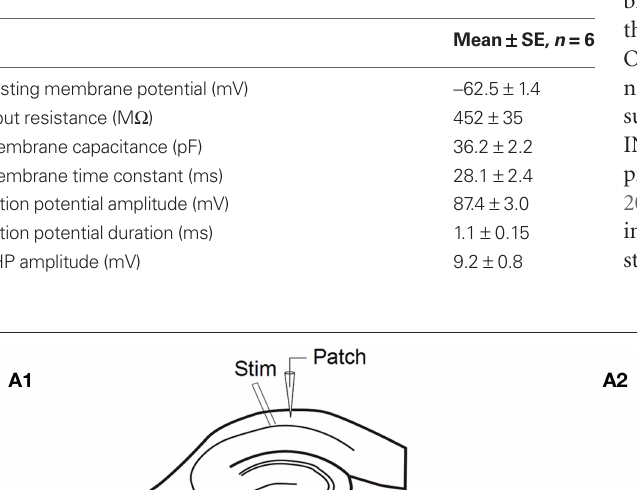
FiGure 4 | input-specific properties of inhibitory synapses onto O–LM iNs. (A) Schematic of the recording and stimulation configuration in hippocampal (A1) and septohippocampal (A2) slices. (B) Sample traces of IPSCs (10 consecutive traces with an average trace shown in black) evoked in O–LM INs by local minimal stimulation in PYR adjacent to st. radiatum